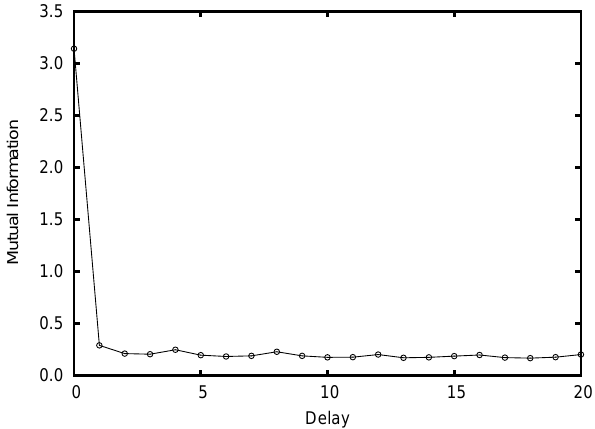
Fig. 6. Mutual information of the time series of the measured DMWS data.